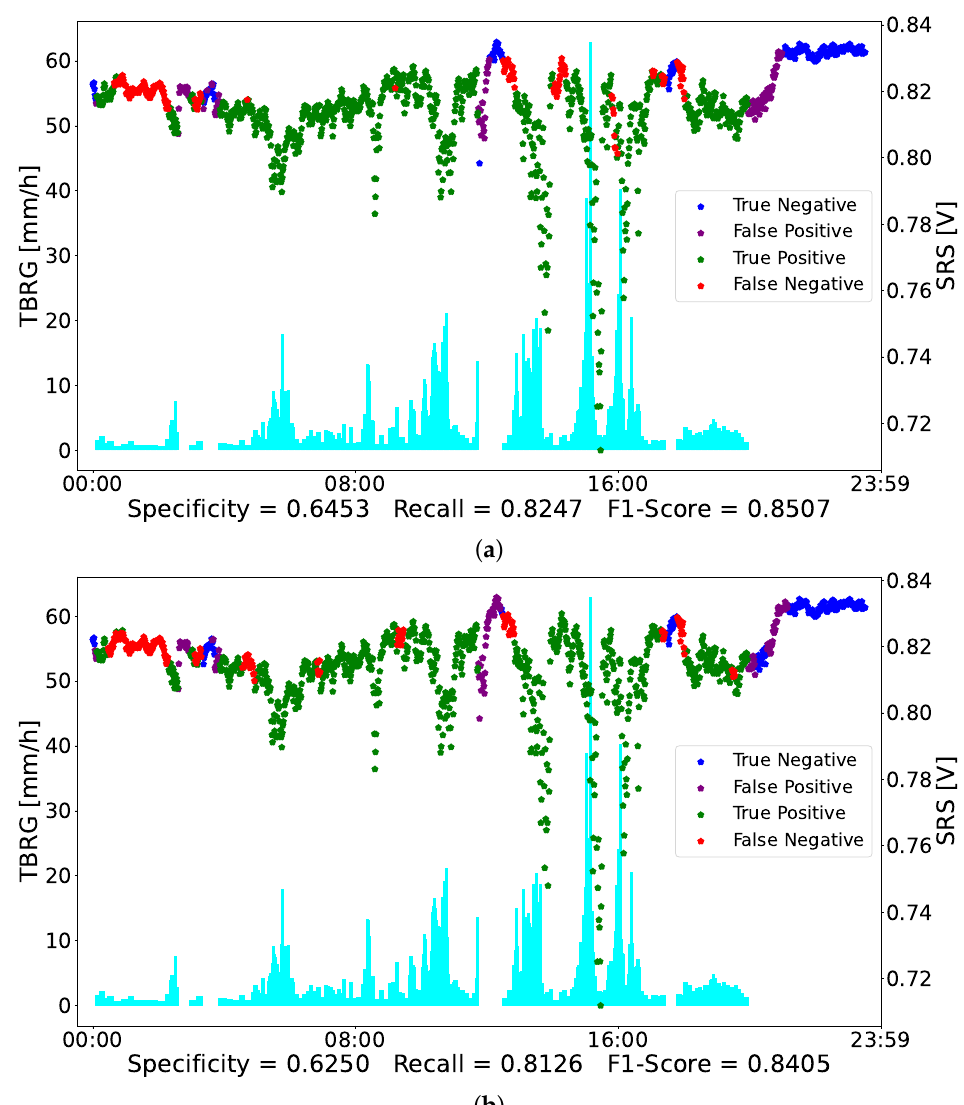
Figure 4. Day 11 classified by NN trained with 12 features ( a ) and with 6 features ( b ). The blue dots refer to not-rainy observations correctly classified, the purple ones are not-rainy observations classified as rain, the green ones are rainy observations correctly classified, and the red dots represent rainy observations classified as not rain. The cyan bars represent the TBRG measurements different from 0 mm/h, i.e., associated with the rain observations. ( a ) Day 11 Neural Network 12 Features. ( b ) Day 11 Neural Network 6